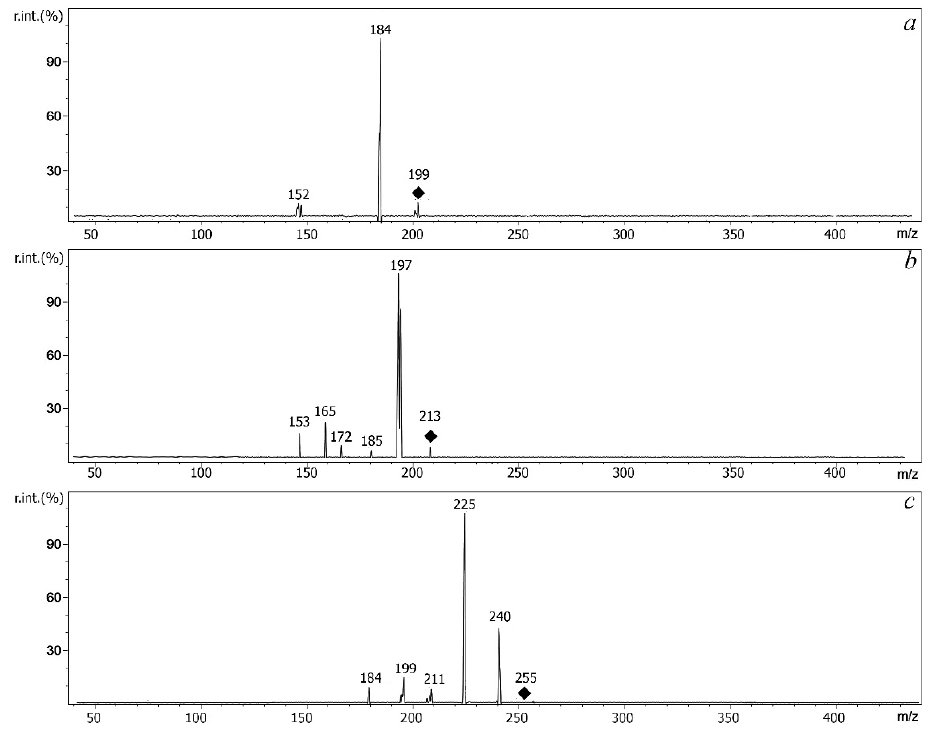
Figure 3. CID mass spectra (collision energy 30 eV) of S-methylsulfonium cations corresponding to